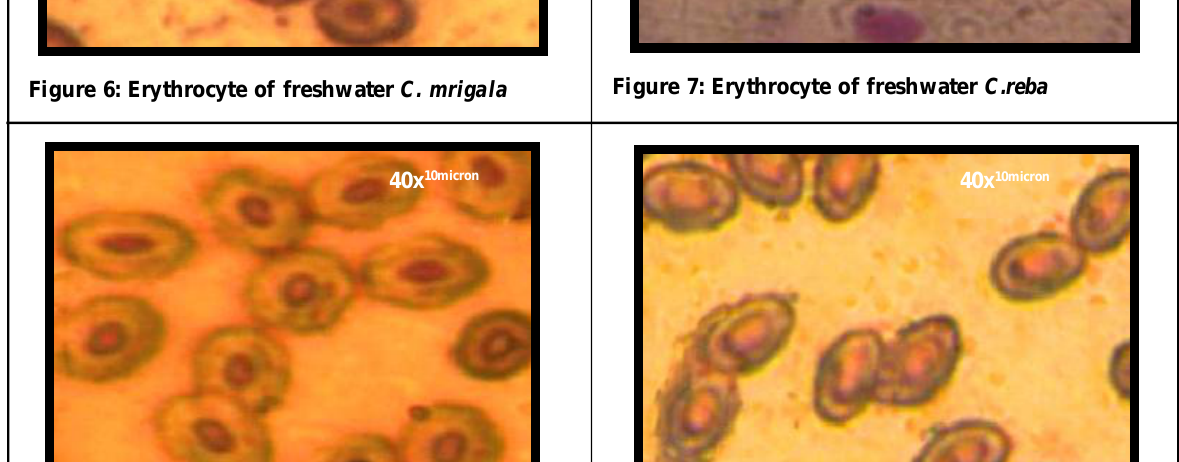
Figure 4: Erythrocyte of freshwater L.rohita Figure 5: Erythrocyte of freshwater C. catla